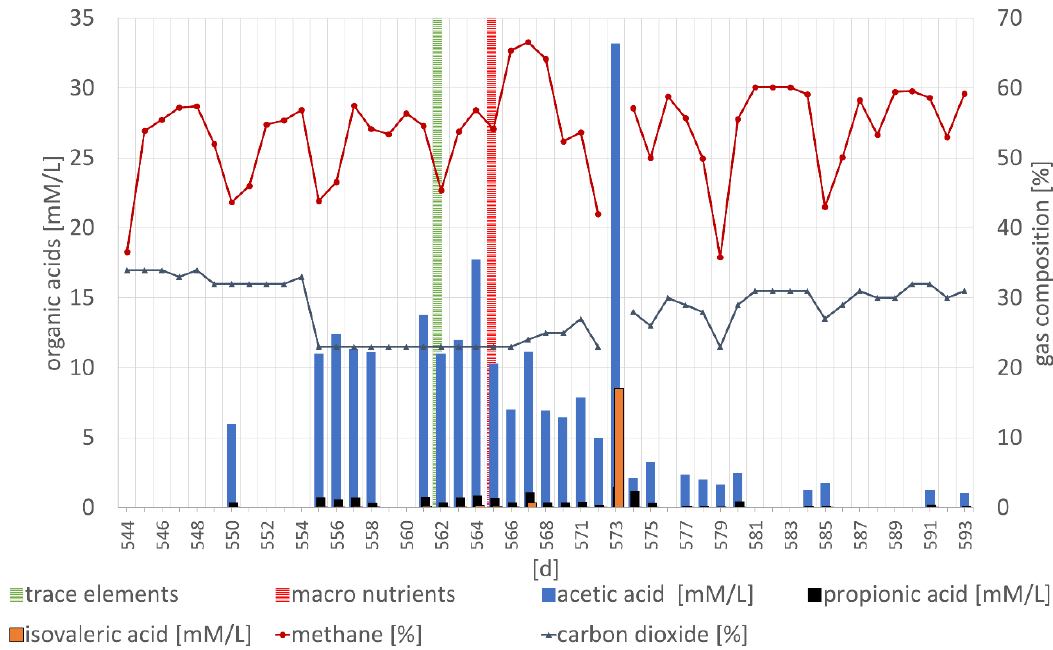
Figure 3. Specific daily biogas production, VOA/TIC, total phosphorous, total nitrogen, ammonium, and organic loading rate of the continuous biogas process (40 °C; pH 7.0–8.0, lot B). The days of macronutrient and trace element supplementation are marked.